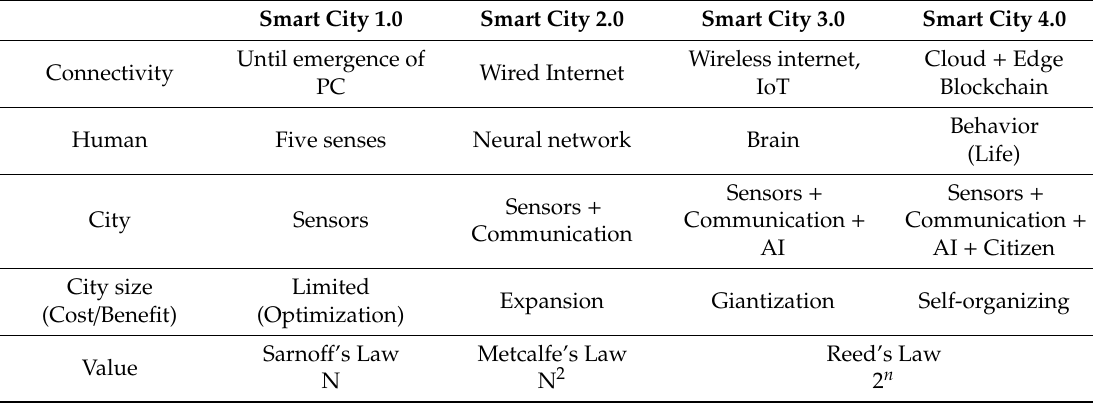
Table 3. Smart City evolution